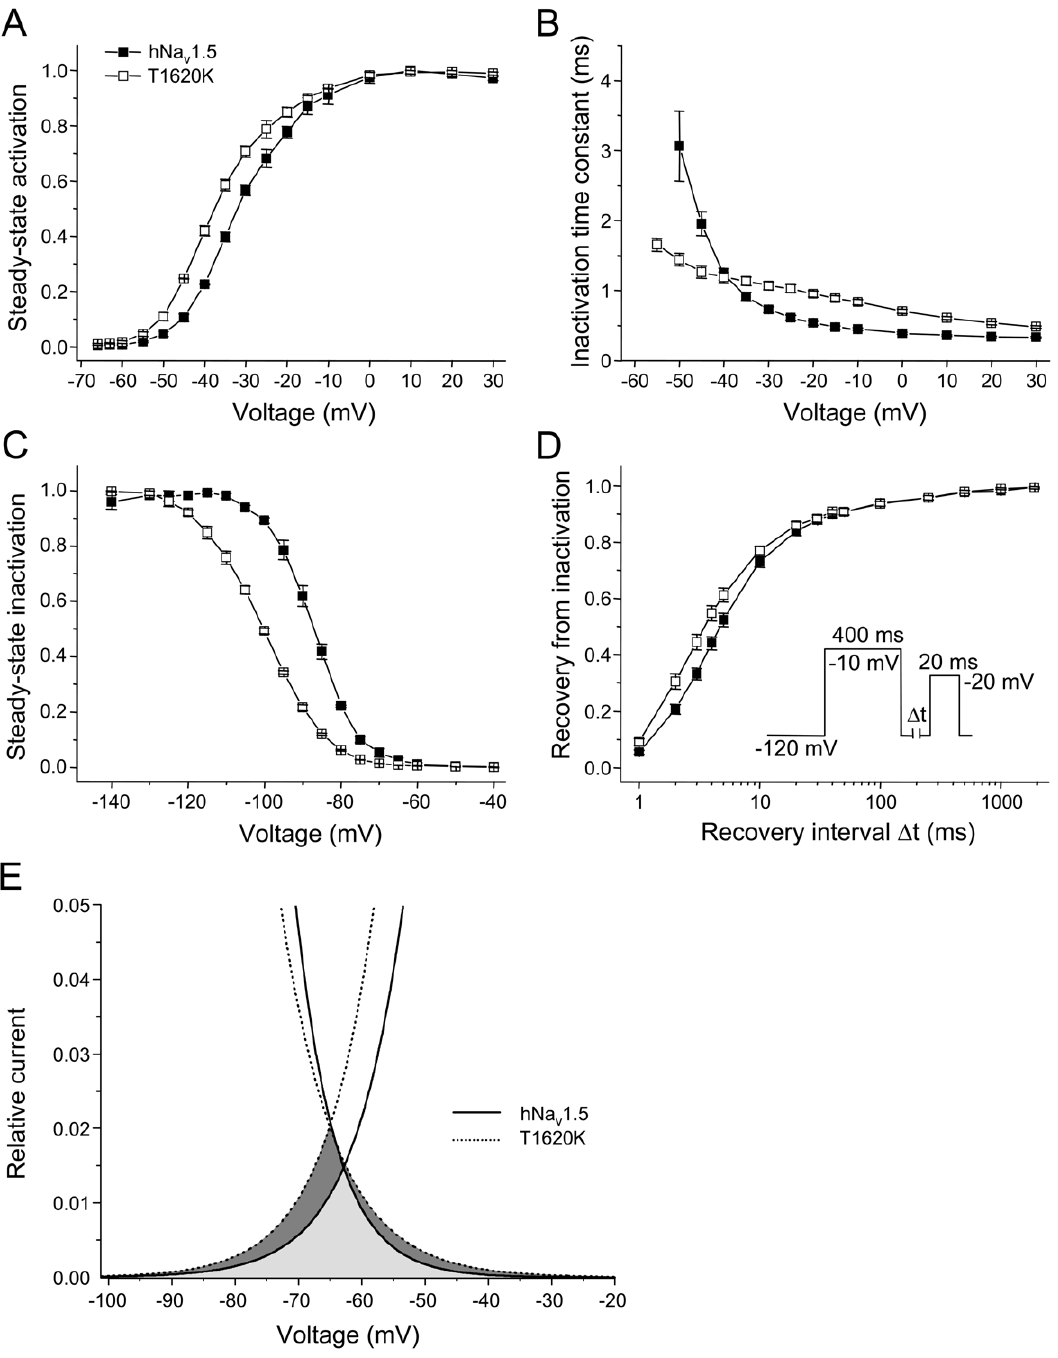
Figure 2. Electrophysiological properties of hNa v 1.5 and mutant T1620K channels. (A) Steady-state activation as function of voltage. (B) Time constants of inactivation as function of voltage. The Na + current decay was fitted with a monoexponential function. (C) Steady-state inactivation as function of voltage. (D) Recovery from inactivation. (E) Illustration of the window current in hNa v 1.5 (light gray) and T1620K (dark gray). Due to the hyperpolarizing shift of steady-state activation (A) and the increased slope of the steady-state inactivation curve (C) both the amplitude and the voltage range of the window current is increased. Gain-of-function features, most likely resulting in prolonged ventricular action potentials and thus in LQT3, are the slower current decay at potentials positive to 2 40 mV (B), the faster recovery from inactivation (D), and the larger window current (E) [5,29]. Loss-of-function features, most likely resulting in conduction slowing and thus in CCD, are the faster current decay at potentials negative to 2 40 mV (B), and the reduced steady-state availability at the resting membrane potential (C) [5,29]. Individual curves illustrating steady-state activation (A), steady-state inactivation (C), and recovery from inactivation (D) were drawn using three representative measurements. Bars indicate S.E.M. For total number of measurements and statistical data evaluation see Table 2. The corresponding peak current densities are shown in Table 3.